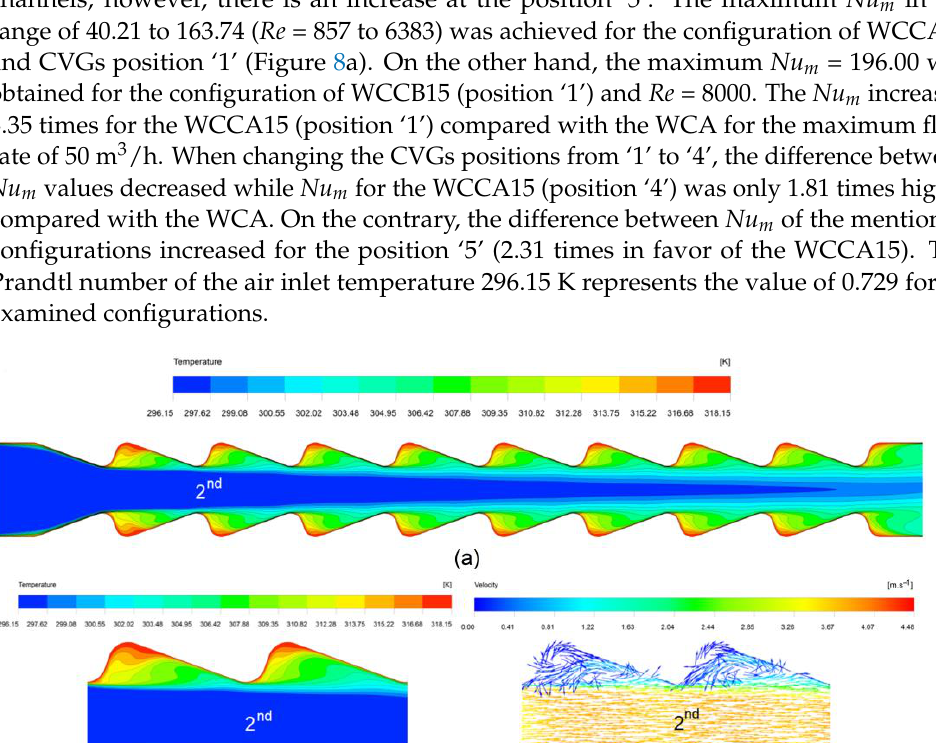
Figure 7. The temperature fields and velocity vectors of the WCB configuration ( Q = 50 m 3 /h), ( a ) temperature fields along the channel, ( b ) detail of the 8th protrusion — temperature fields, ( c ) detail of the 8th protrusion — velocity vectors. When comparing the WCA, WCB, and wavy channels with CVGs (10 mm, 15 mm), the first mentioned configuration achieved lower Nu m for all investigated CVGs positions (Figure 8). It was found that Nu m decreases with CVGs position (1 to 4) for all wavy chan- nels; however, there is an increase at the position ‘5’. The maximum Nu m in the range of